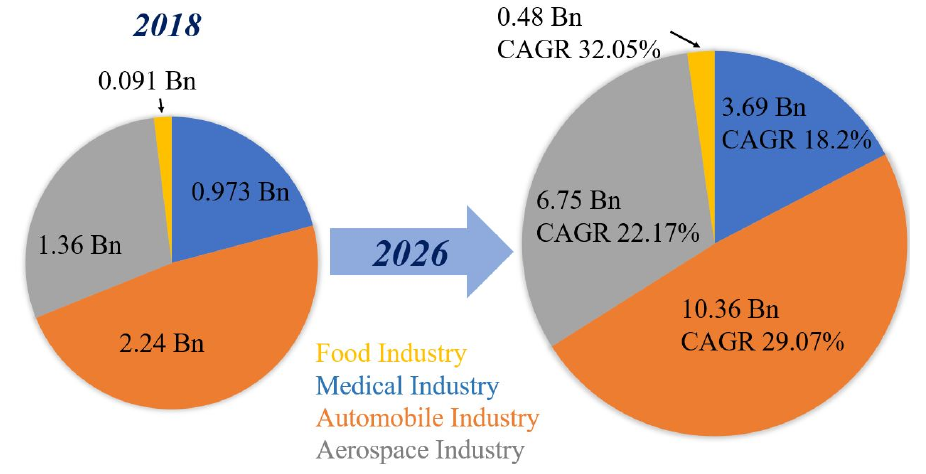
Figure 2. Compound annual growth rate (CAGR) of 3D printing in the food, medical, aerospace and automobile industries from 2018 to 2026 [12–15].